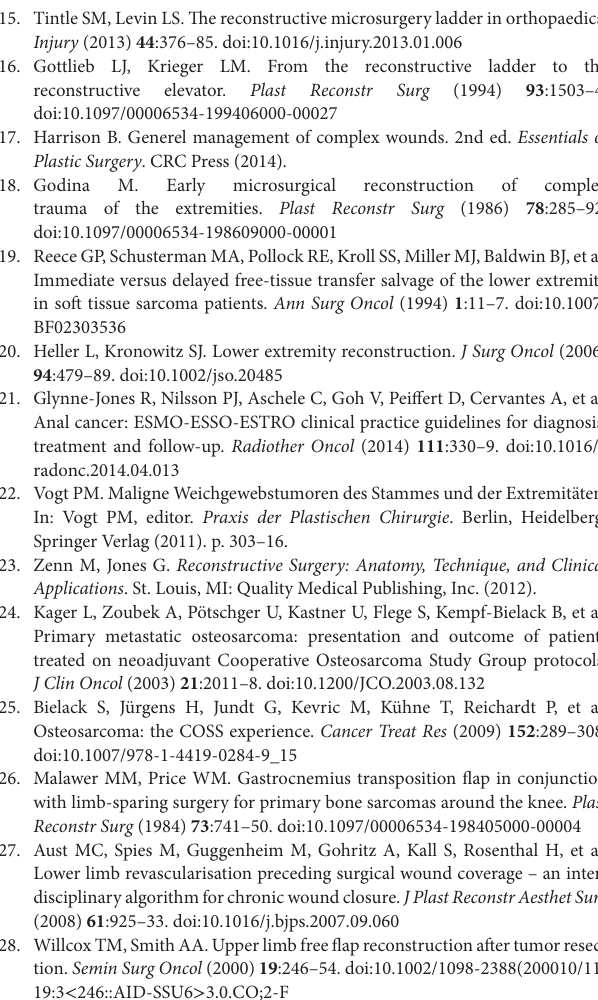
disciplinary algorithm for chronic wound closure. J Plast Reconstr Aesthet Surg (2008) 61 :925–33. doi:10.1016/j.bjps.2007.09.060 28. Willcox TM, Smith AA. Upper limb free flap reconstruction after tumor resec- tion. Semin Surg Oncol (2000) 19 :246–54.